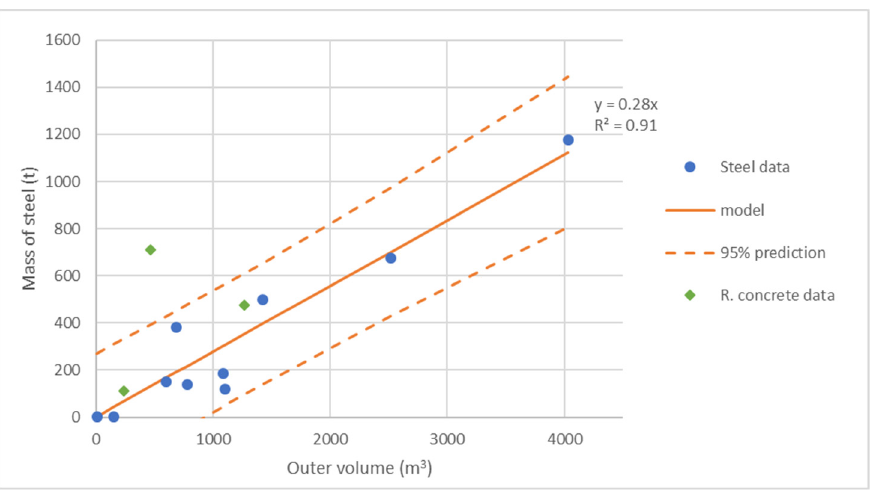
Figure 6. Linear regression of data points found for the mass of the steel structure (not including ballast) versus total hull volume for floating WECs, with 95% prediction